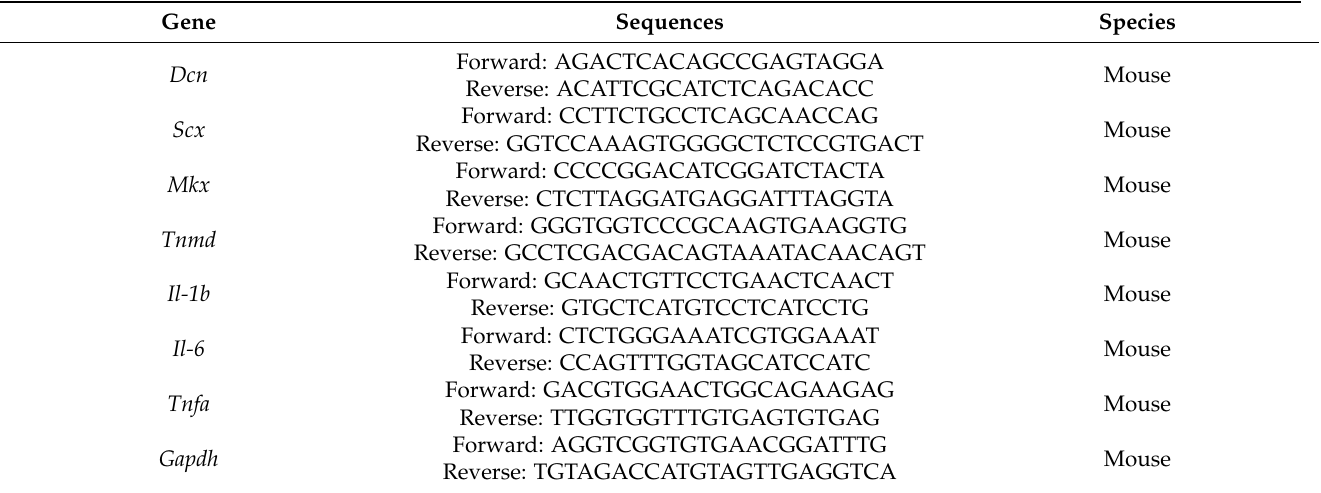
Table 2. Primers for real-time RT-PCR used in this